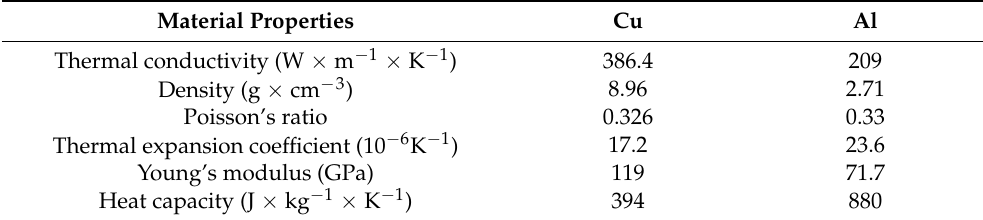
Table 1. Material properties of Cu/Al laminate applied for numerical